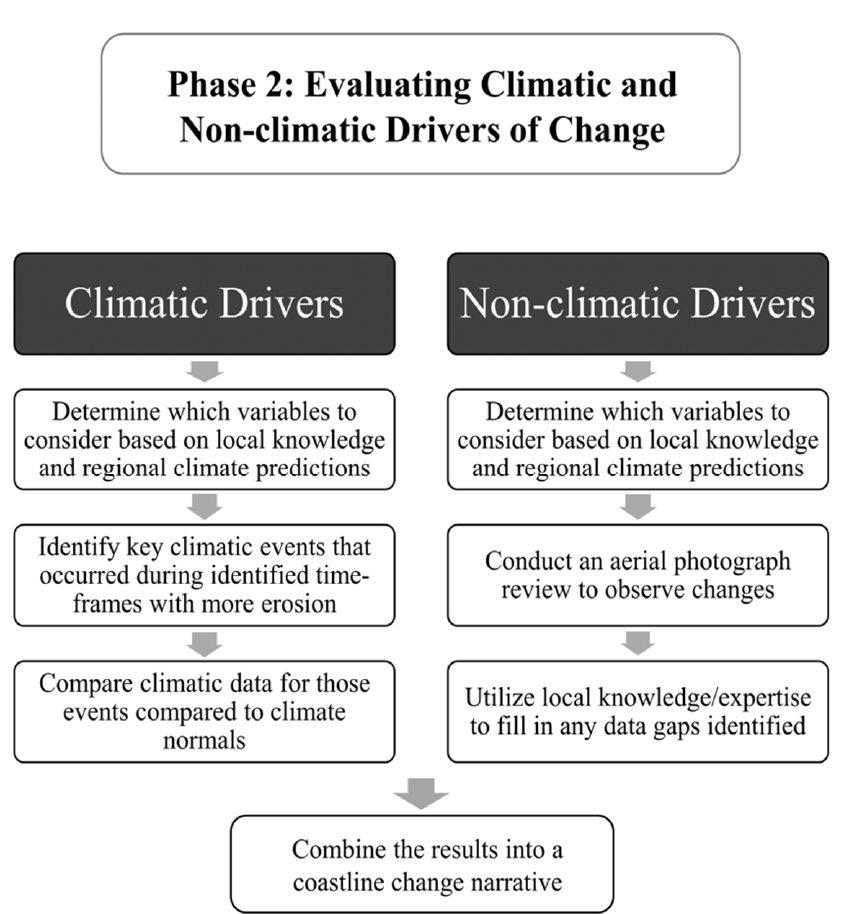
Figure 4. Phase Two of the methodological approach involves a series of actions that summate to creating a descriptive narrative for how and why the coastline may have evolved based on select climatic and non-climatic drivers of change.